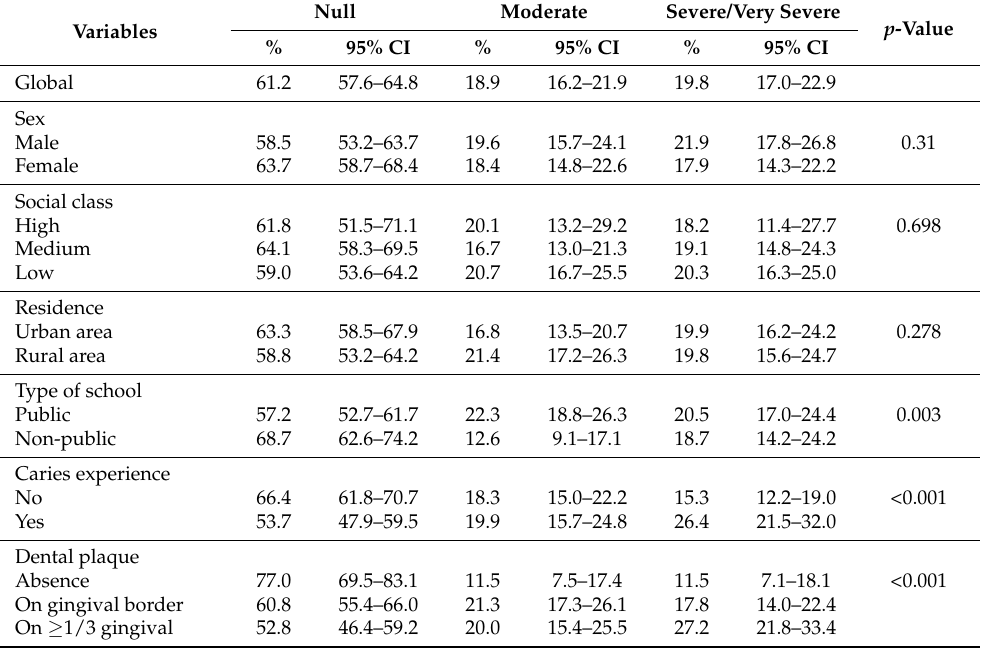
Table 3. Presence and severity of malocclusion by socio-demographic and oral health variables and estimation of the association between the presence of malocclusion and the different variables in 12-year-old schoolchildren.